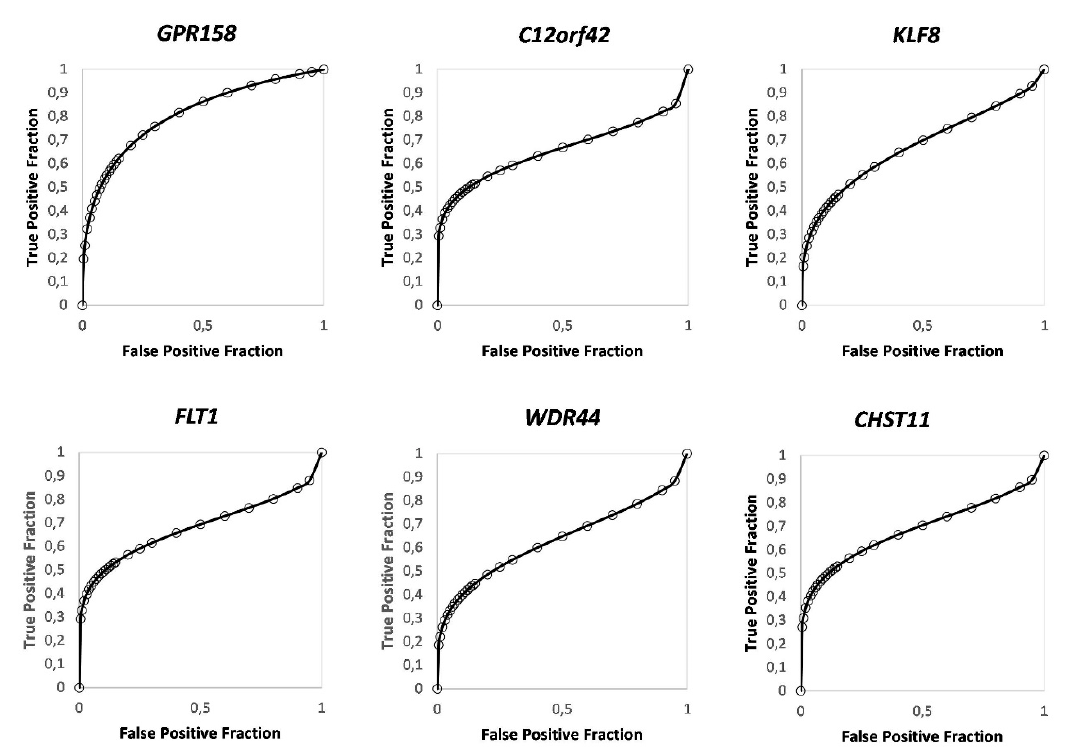
Figure 5. Receiver operator curves (ROC) and areas under the curve (AUCs) for the six DMRs.